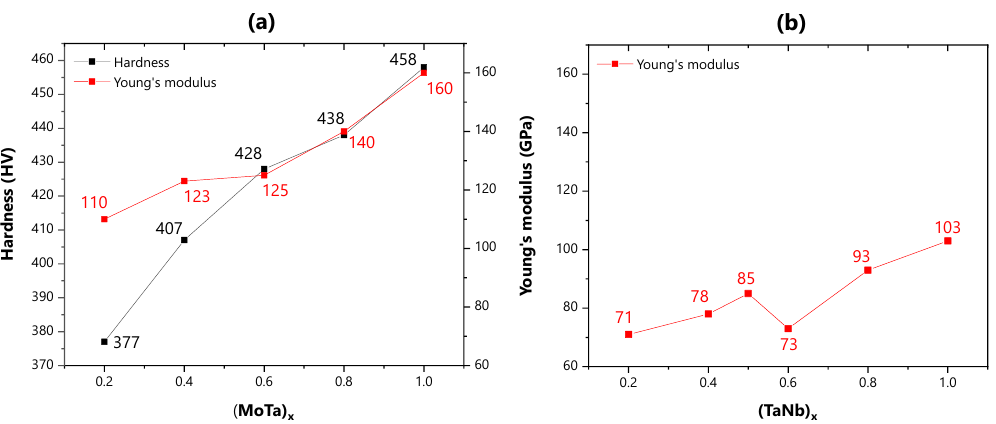
Figure 2. ( a ) Evolution of hardness and Young’s modulus as a function of MoTa ratio for (MoTa) x NbTiZr. Based on [41]; ( b ) Evolution of Young’s modulus as a function of Ta and Nb ratio for Ta x Nb x HfZrTi. Based on